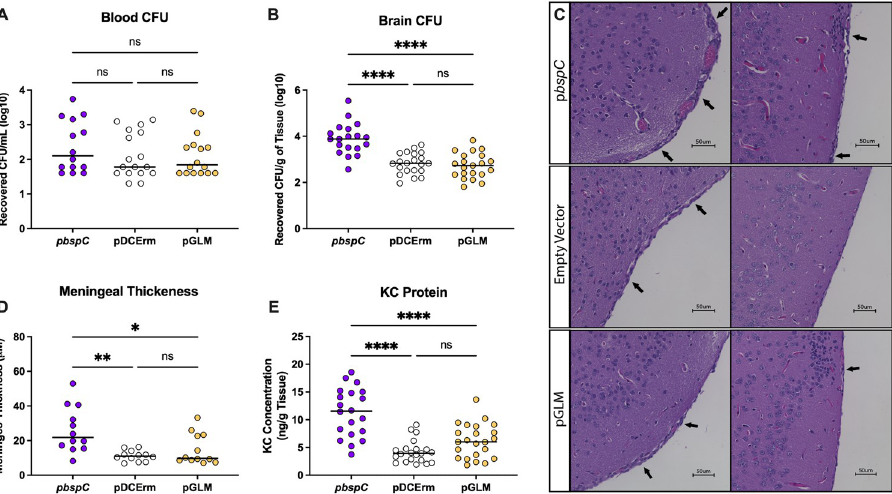
Fig 4. Flexibility of the Pocket-Guarding Gating Loop is Required for GBS Meningitis. Mice were infected with ~4x10 8 CFU of COH1 Δ bspC GBS containing pDCErm bspC (p bspC ), the empty vector (pDCErm), or pDCErm bspC GLM (pGLM) and then sacrificed after 48 hours. (A) Half of each mouse brain was homogenized and plated on THA-Erm to determine bacterial burden. (B) Blood from each mouse was also plated on THA-Erm to determine bacterial burden. For (A) and (B) , data is pooled from three independent experiments, where each dot represents an individual mouse, and lines indicate statistical means. (C) H&E stains showing representative images of the leptomeninges from two individual mice per group. Arrows indicate areas of leukocyte infiltration and meningeal thickening. (D) ImageJ was used to analyze meningeal thickness from 3 mice per group. Two images were taken of each brain, and three distinct regions per image were measured with each dot representing an individual region. (E) KC protein concentration was quantified via ELISA from the brain homogenates shown in A. Data for E is pooled from three independent experiments, where each dot represents an individual mouse brain, and lines indicate statistical means. Statistical analysis: (A, B, C, and D) One-way ANOVA with Tukey’s multiple comparisons. � , P < 0.05; �� , P < 0.005; ���� , P <